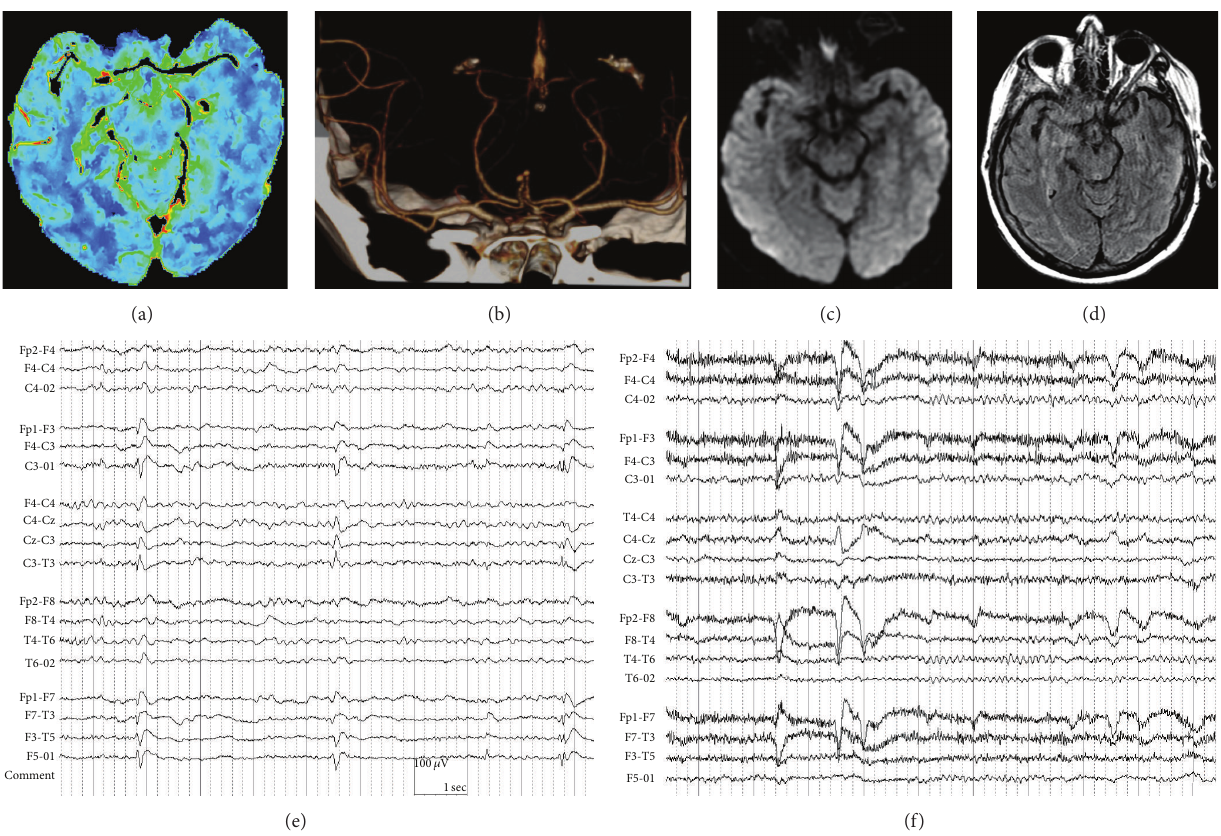
Figure 1: (a) Symmetric blood volume demonstrated on CT perfusion scan, in a 79-year-old woman presenting with a classic left MCA syndrome. (b) The absence of a proximal vessel cut-off in a CT angiogram reconstruction of the circle of Willis. (c) The absence of restricted diffusion in an MRI brain. (d) The absence of FLAIR hyperintensities indicative of an acute ischemic stroke or herpes simplex encephalitis. (e) Left anterior and midtemporal periodic lateralized discharges seen on hospital day 2, with a notable background which is diffusely slow, and an absence of a posterior dominant rhythm (PDR). (f) Return of the PDR of 8-9Hz and the absence of PLEDs after the institution of intravenous valproic acid and acyclovir